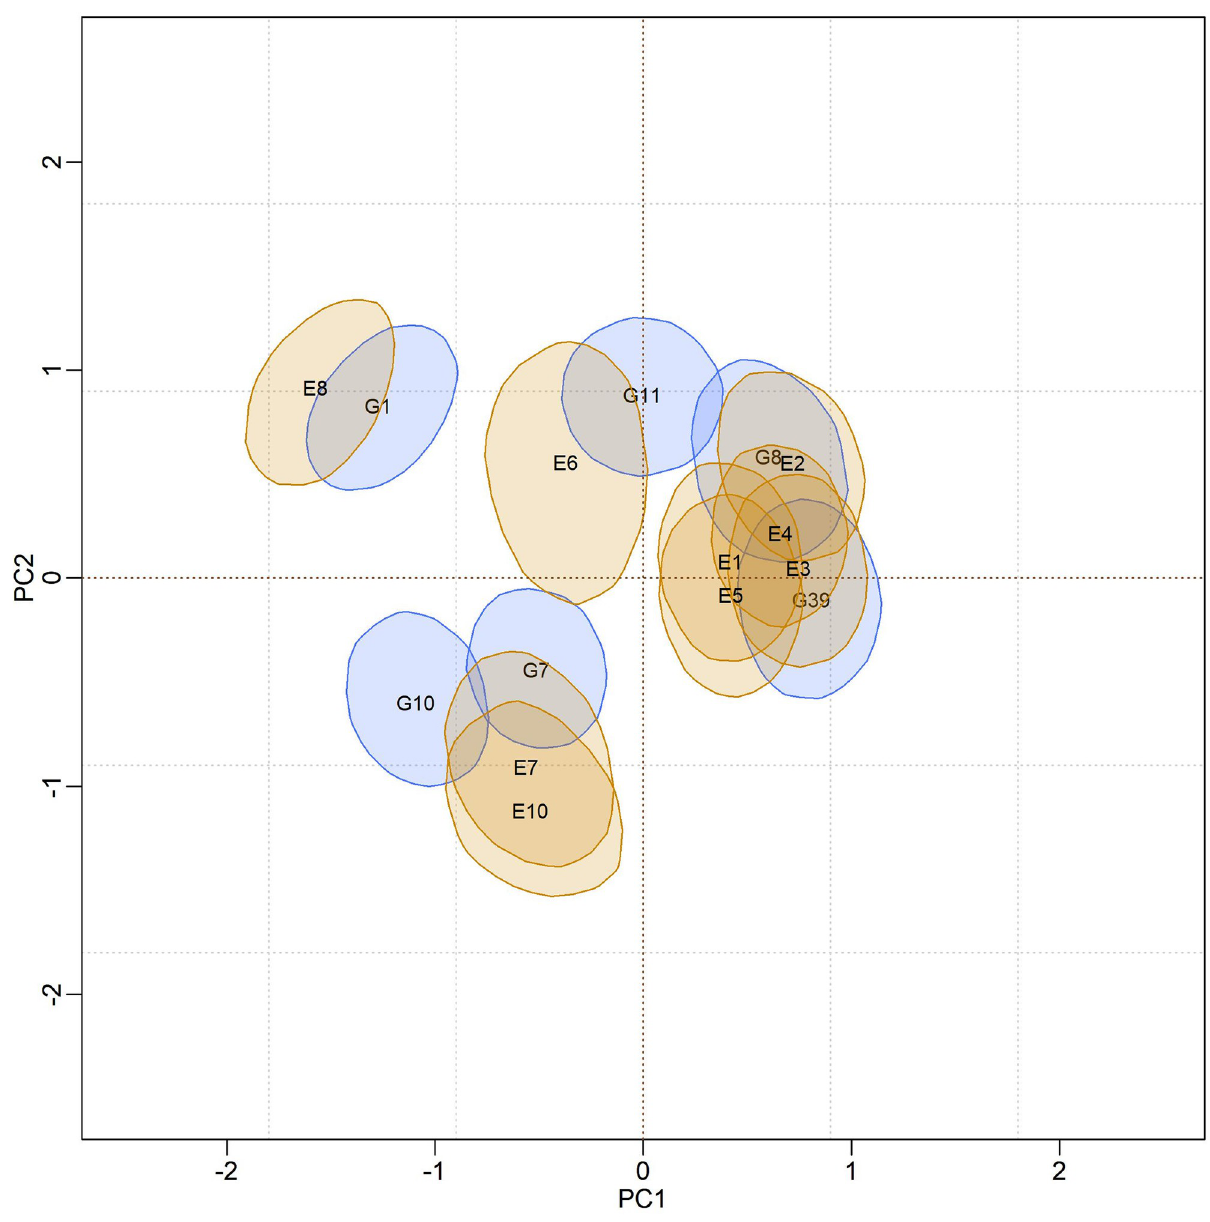
Fig 20. Bivariate credibility regions at 95% probability for the genotypic and environmental scores of the BAMMIS-3 model for real data, adjusted using the MCMC method. Only regions whose regions do not contain the origin (0.0) were plotted.